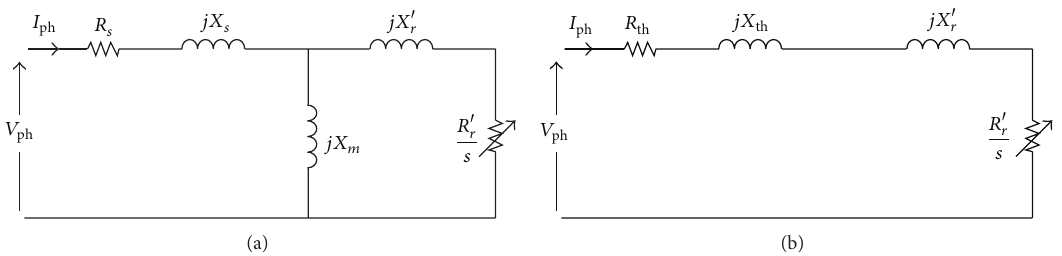
Figure 1: (a) One phase steady-state equivalent circuit model of a three-phase induction motor; (b) Th´evenin equivalent circuit of induction motor.